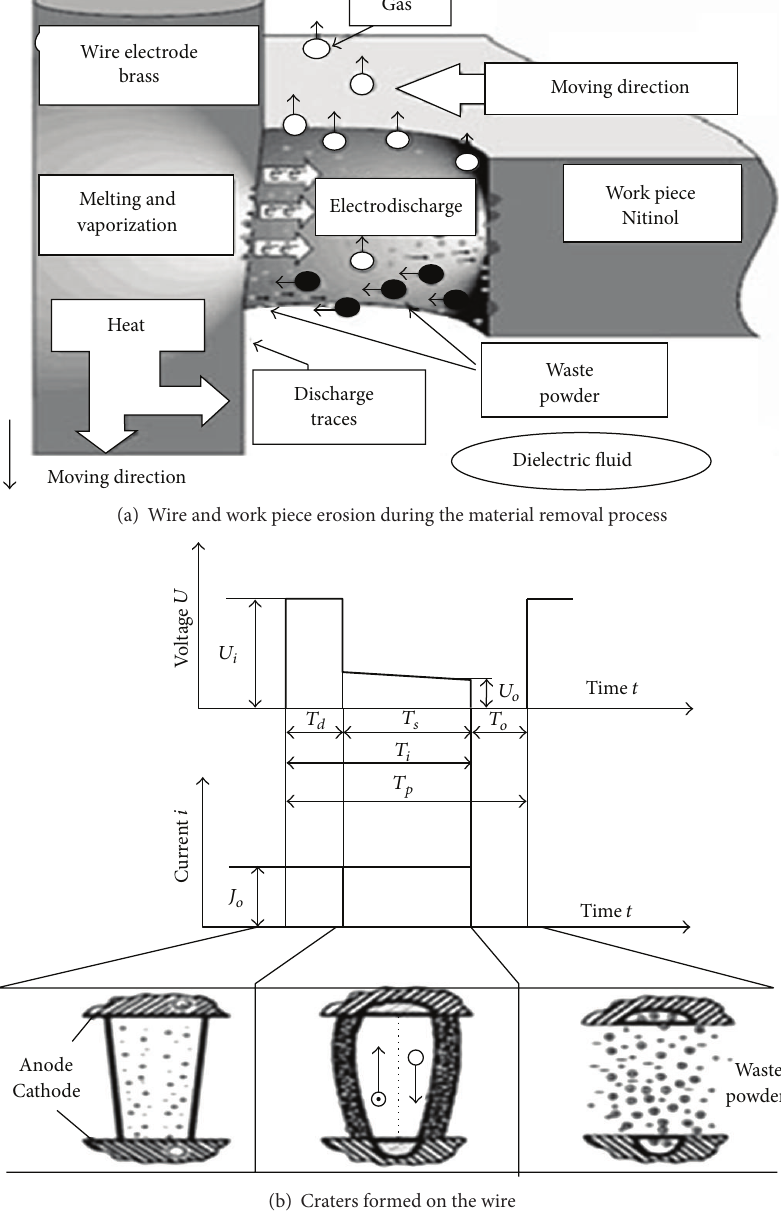
Figure 2: Schematic image of machining process with